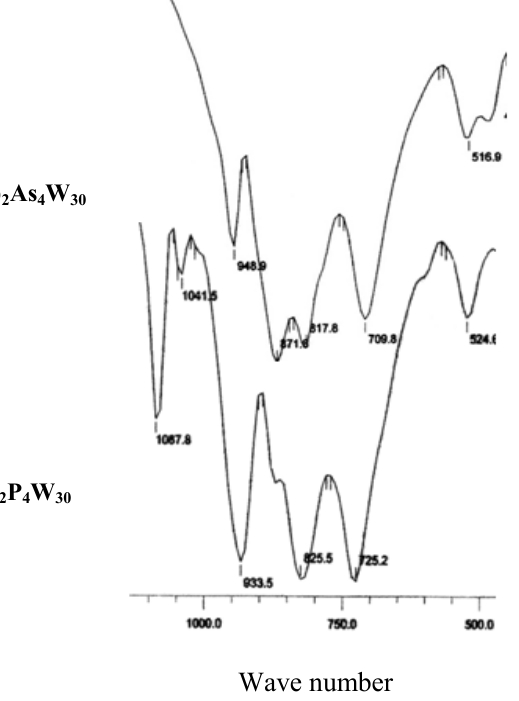
Figure 1. IR spectrum of Na